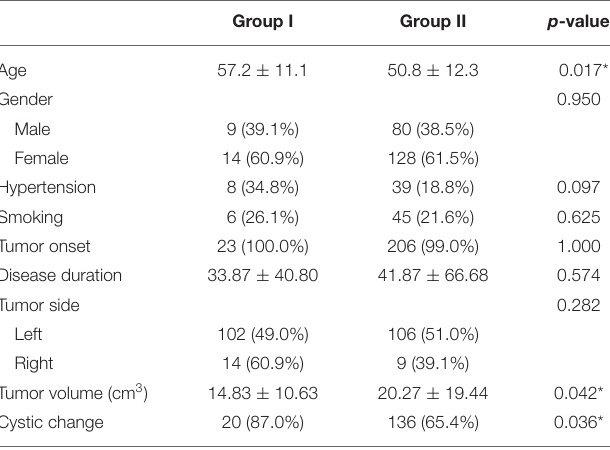
TABLE 3 | Comparison of clinical characteristics in patients with acoustic neuroma that coexisted with intracranial aneurysm or not.